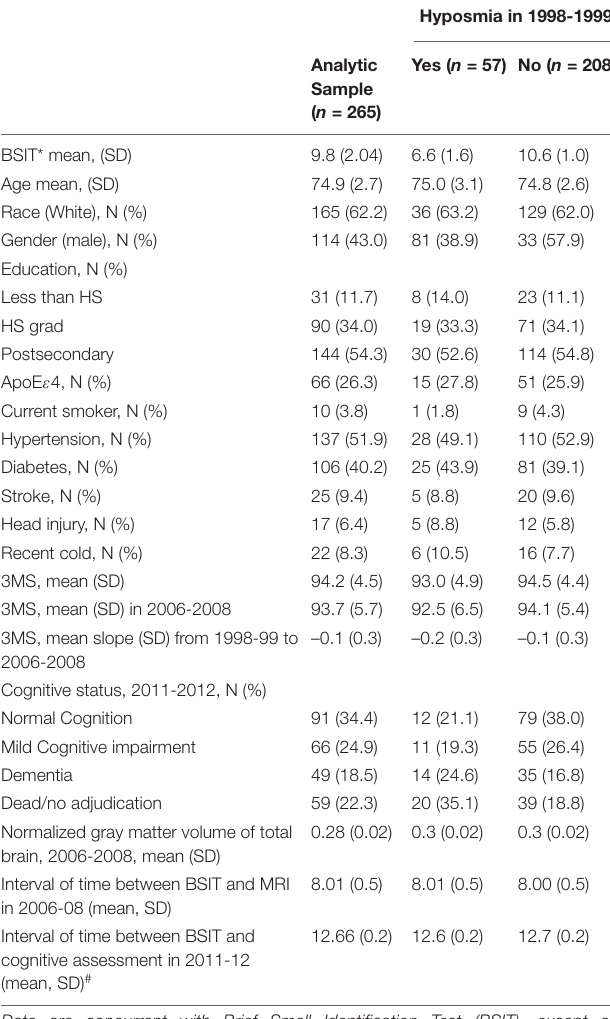
TABLE 1 | Participant characteristics and associations with